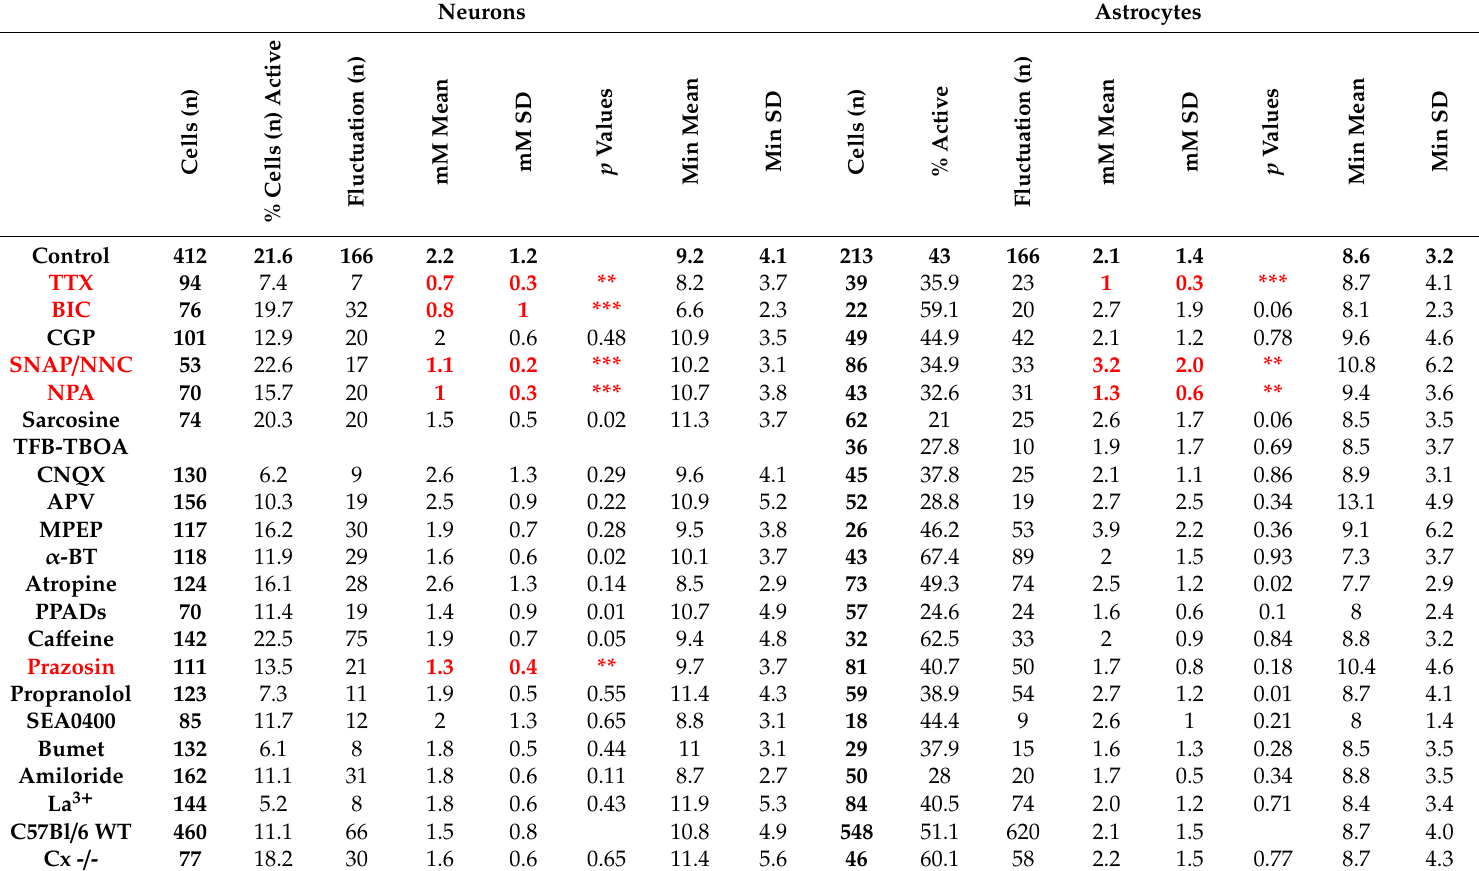
Table 2. Number of neurons (left) and astrocytes (right) measured, the % of these showing activity, the total number of fluctuations analyzed under each condition. and the mean and standard deviation for the amplitude (mM) and duration (minutes) for the analyzed